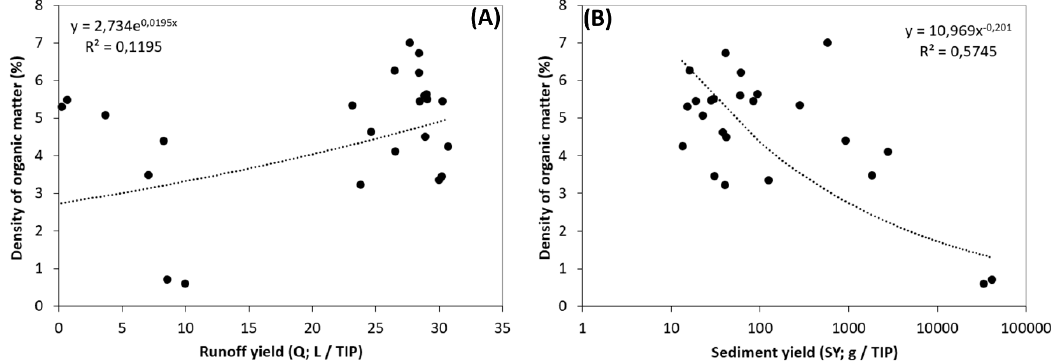
Figure 4. Relationship between the concentration or density of OM in the sediment and the amount of runoff (Q) ( A ) and sediment yield (SY) ( B ) per time-integrated period (TIP).